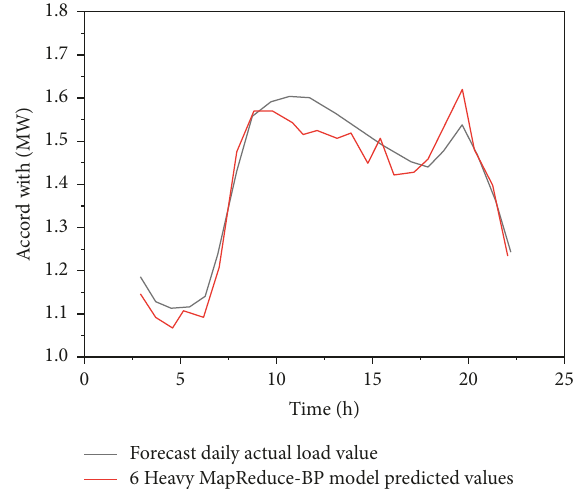
Figure 6: Load forecasting results of the neural